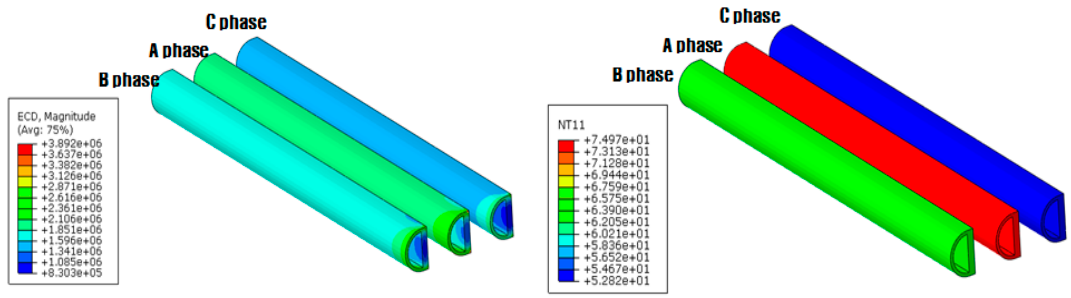
Figure 8. Electromagnetic and thermal analysis for 3-phase parallel array of tunnel-type bus-bar.